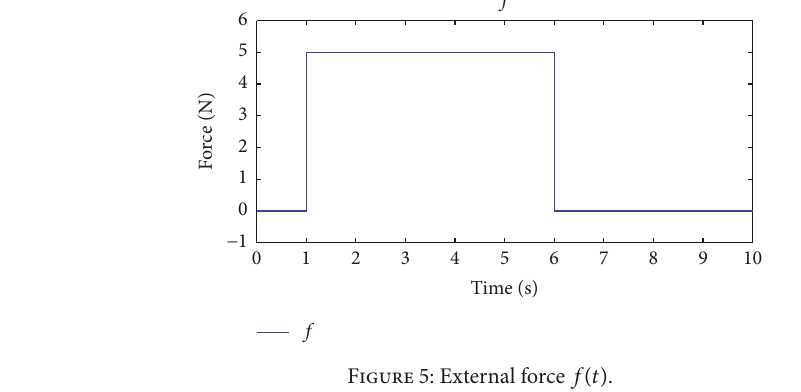
Figure 5: External force 𝑓(𝑡) .